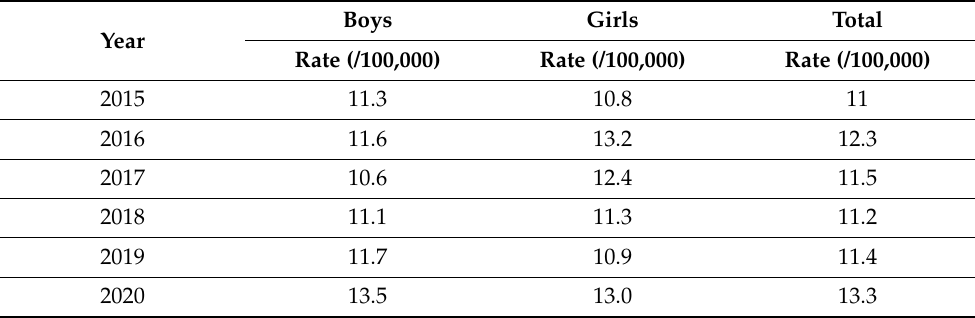
Table 1. Crude incidence rates for type 1 diabetes mellitus in Romanian children (0–14 years)